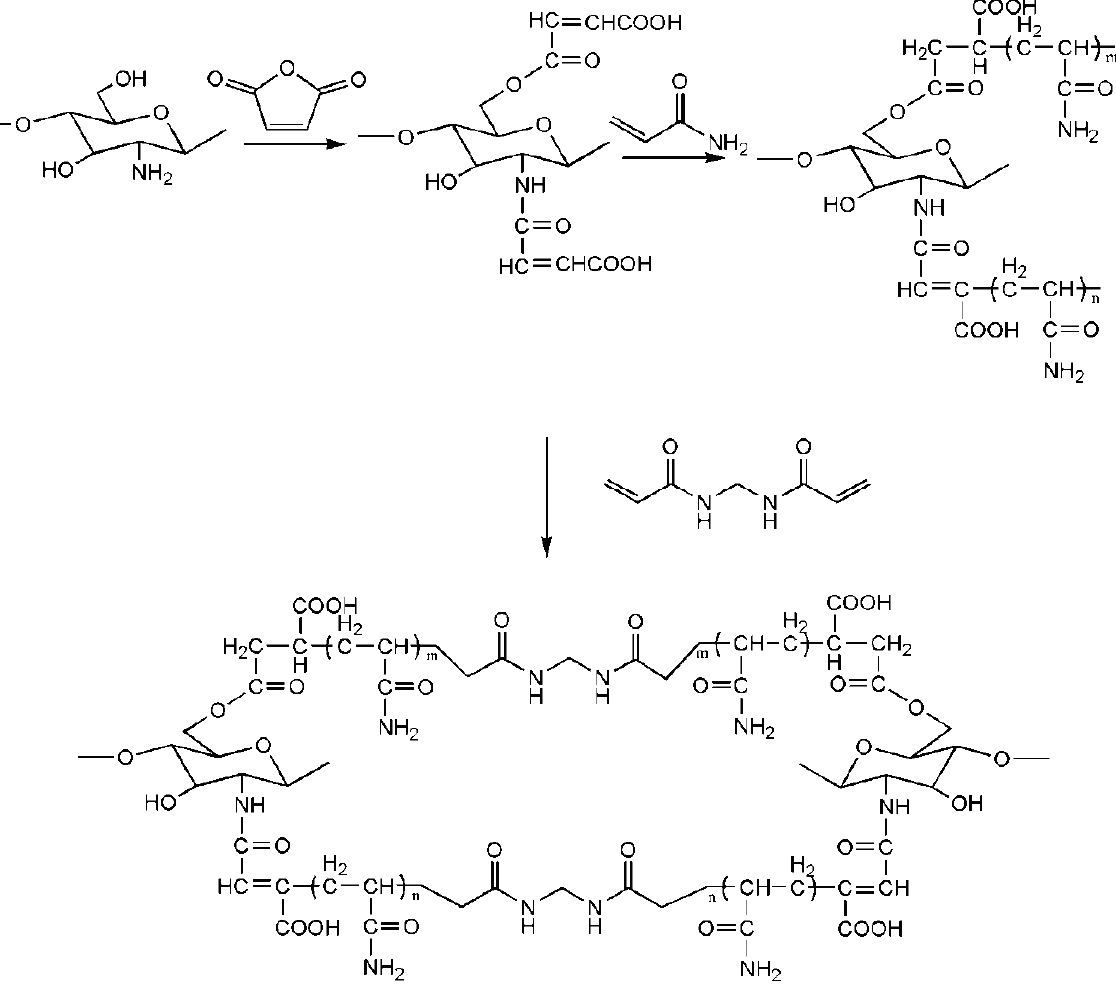
Figure 8. Cross-linking mechanism of maleic anhydride-modified chitosan and